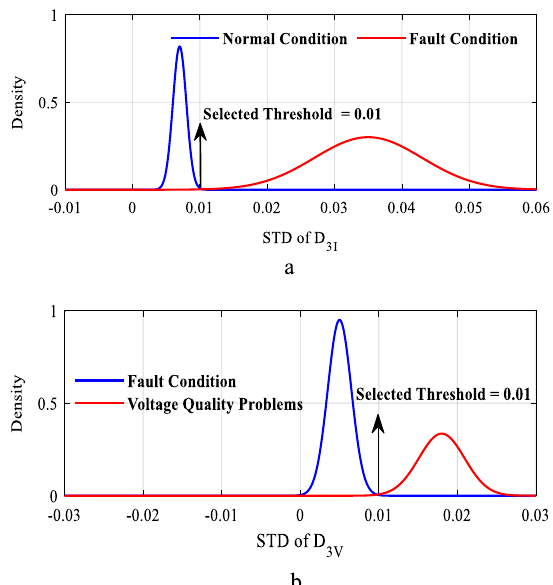
Fig. 7 The threshold selection process using Otsu thresholding method. a PDF curves of normal condition and fault condition for selecting a threshold value of current criterion, b PDF curves of voltage quality problem and fault condition for selecting a threshold value of voltage